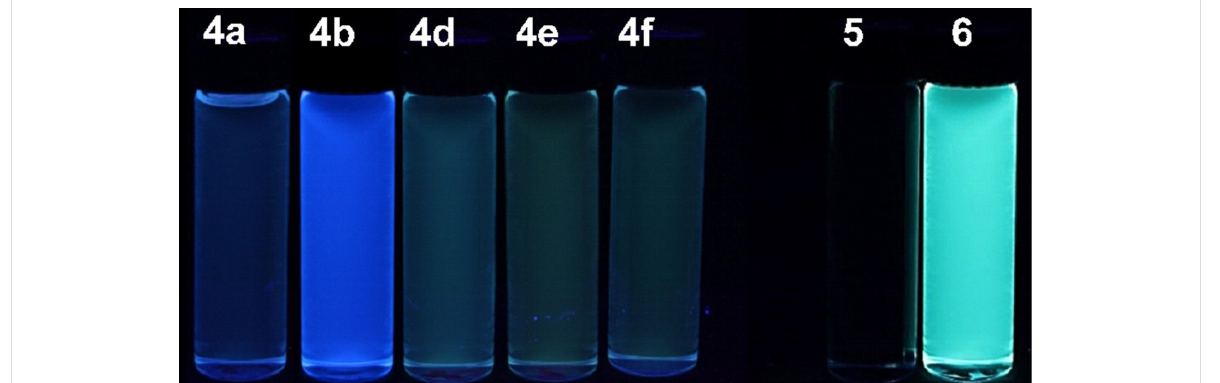
Figure 4: Emission properties of compounds 4a , b , d–f , 5 , and 6 under handheld UV-lamp ( λ exc ≈ 350 nm).